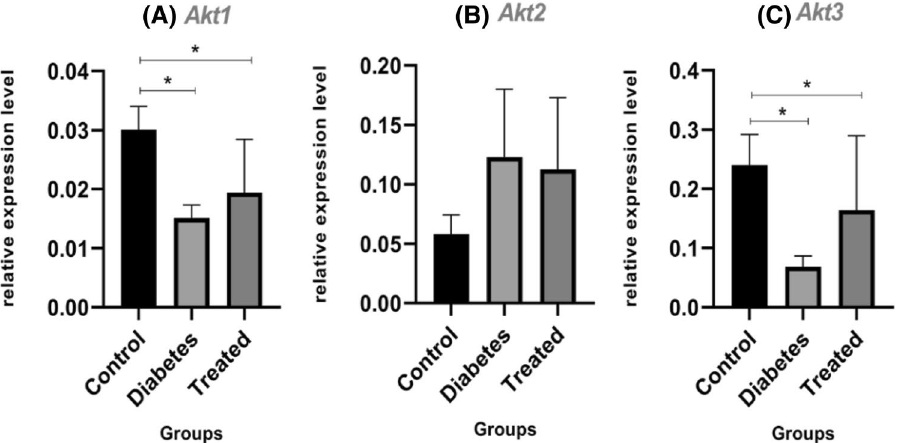
Figure 7. Relative expression of Akt genes in the hippocampus between control, diabetic and diabetic groups treated with RA, by real-time PCR. In the diabetic and treated groups, respectively, there was a significant down- regulation of 47% and 32% for Akt1 compared to the control group. (* P < 0.05) ( A ). Comparison of the relative expression of Akt3 , between the control group with the diabetic and treated groups showed a significant down- regulation of 67% and 20%, respectively (* P < 0.05) ( B ). There was, however, no significant difference in the Akt2 gene expression between the three groups ( P > 0.05) ( C ). The columns represent the mean ±